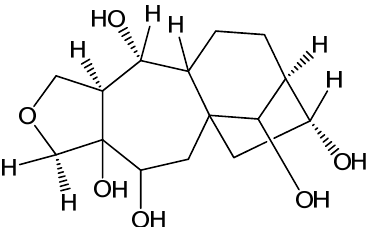
Figure 1. Structure of